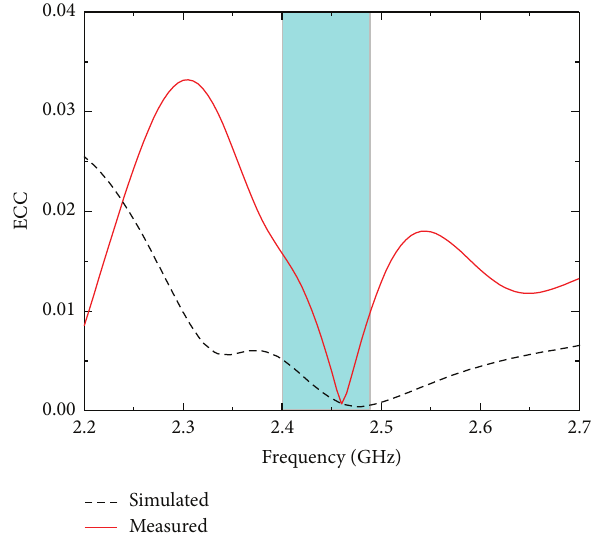
Figure 15: Simulated and measured proposed MIMO antenna’s envelope correlation